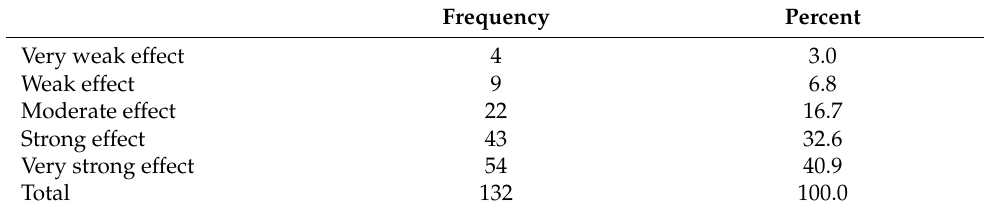
Table 6. Limited and unreliable